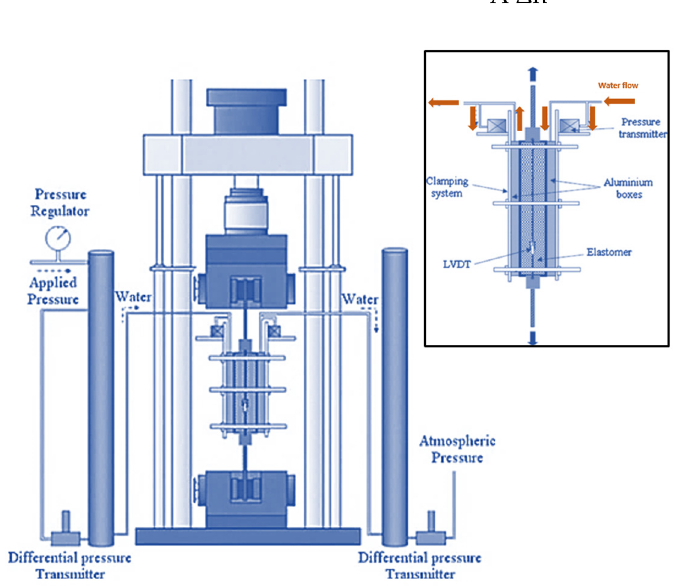
Figure 18. Universal testing machine with water permeability device (Adapted with permission from reference [59,60,103]).